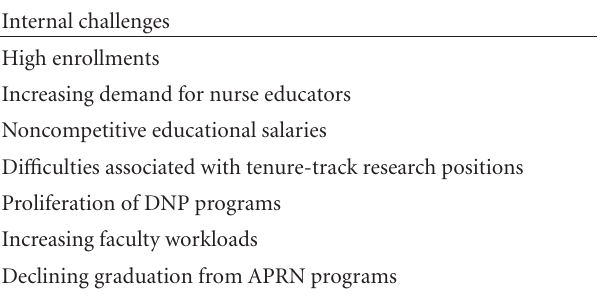
Table 1: Challenges to e ff ective APRN clinical